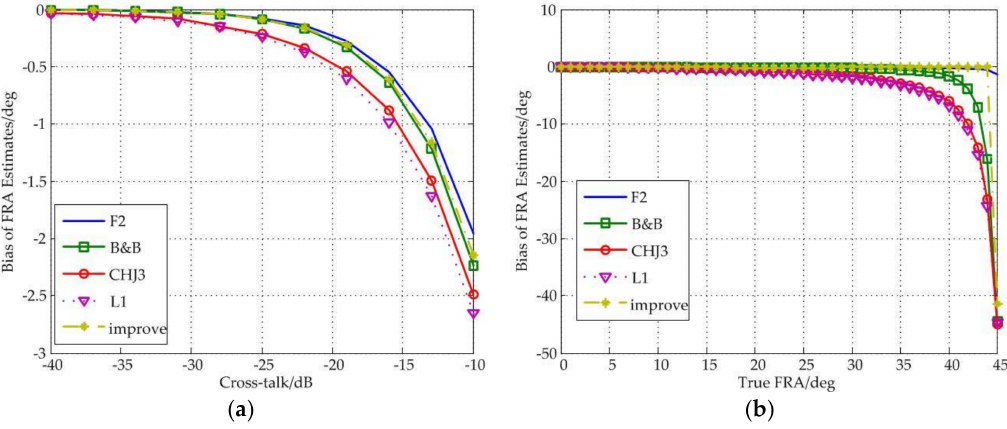
Figure 5. ( a ) Bias of FRA estimates as a function of cross-talk under different estimators; ( b ) Bias of FRA estimates as a function of true FRA under different